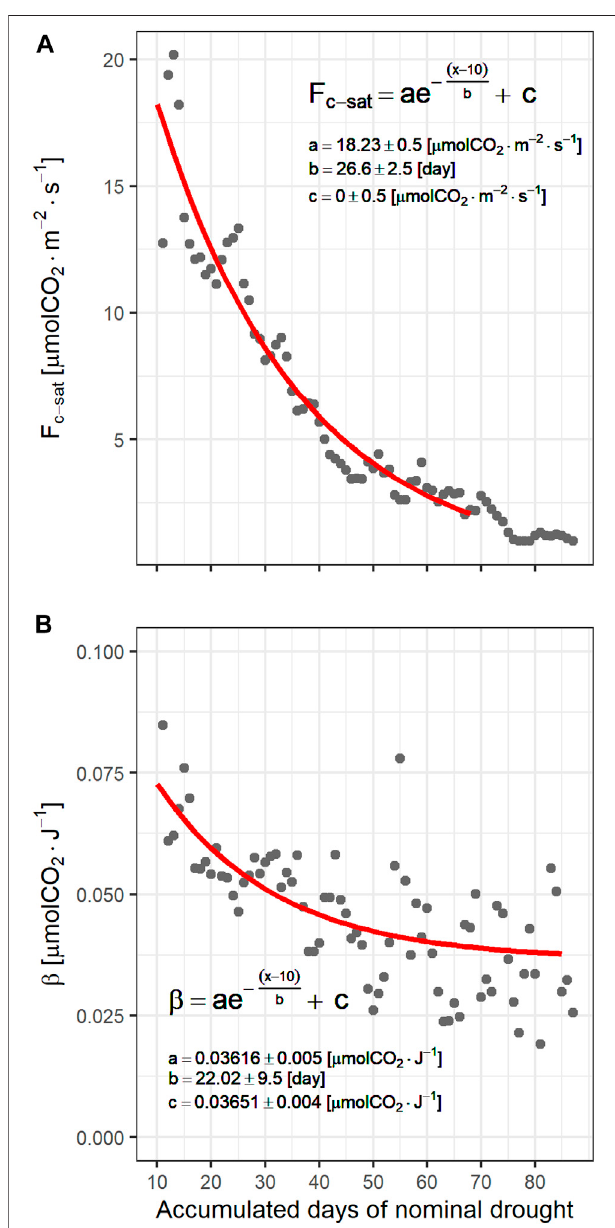
FIGURE 7 | Dependence of (A) NEE at light saturation ( F c − sat ), (B) photosynthetic ef fi ciency ( β ) on drought duration. Coef fi cient uncertainties are ± 1 standard deviation (68% CI).